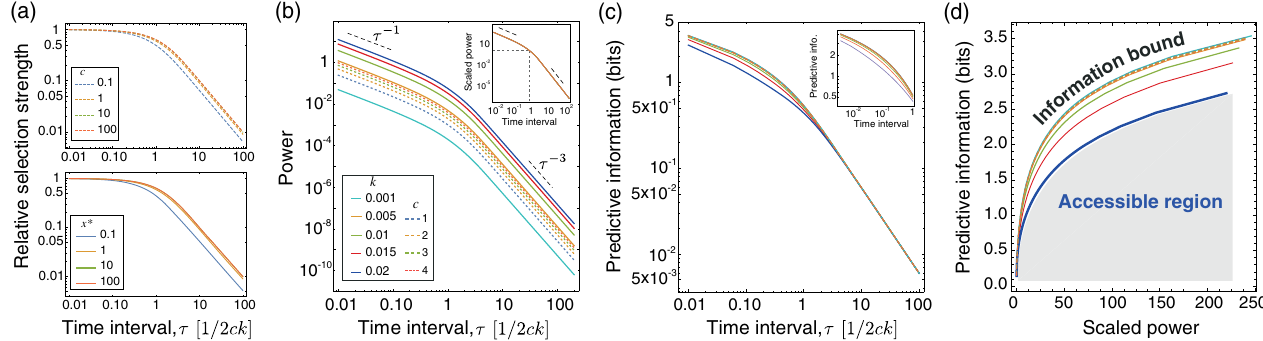
FIG. 4. Artificial selection with limited information. (a) Relative strength of artificial selection α τ = α 0 [Eq. (11)] is shown as a function of the time interval for monitoring and intervention τ , measured in units of the characteristic time for evolution under natural selection ( 1 = 2 kc ). The selection ratio is shown for various strengths of natural selection c (top, with x (cid:3) ¼ 1 ) and for various targets of artificial selection x (cid:3) (bottom, with c ¼ 1 ). (b) Power [Eq. (13)] is shown as a function of the time interval τ for a range of parameters for the phenotypic diversity k (full line) and the strength of natural selection c (dotted line). The inset shows a collapse plot for power scaled with the expectation at the characteristic time for natural selection power ð τ Þ = power ð τ ¼ 1 Þ . (c) Predictive mutual information I ð τ Þ [Eq. (14)] is shown to decay with the time interval τ for a wide range of parameters ( k , c ). Inset shows an enlargement of a narrower range for the time interval τ < 1 . (d) Predictive information [Eq. (14)] is shown as a function of the scaled power for optimized artificial selection for a range of τ values [Eq. (13)]. Each curve sets an information bound for artificial selection for a given set of evolutionary parameters ( k , c ). A nonoptimal selection intervention should lie below the information curve, shown by the gray shaded area as the accessible region associated with the dark blue curve. Color code in (c) and (d) is similar to (b). Other parameters are λ ¼ 0 . 6 , x (cid:3) ¼ 3 , g ¼ 2